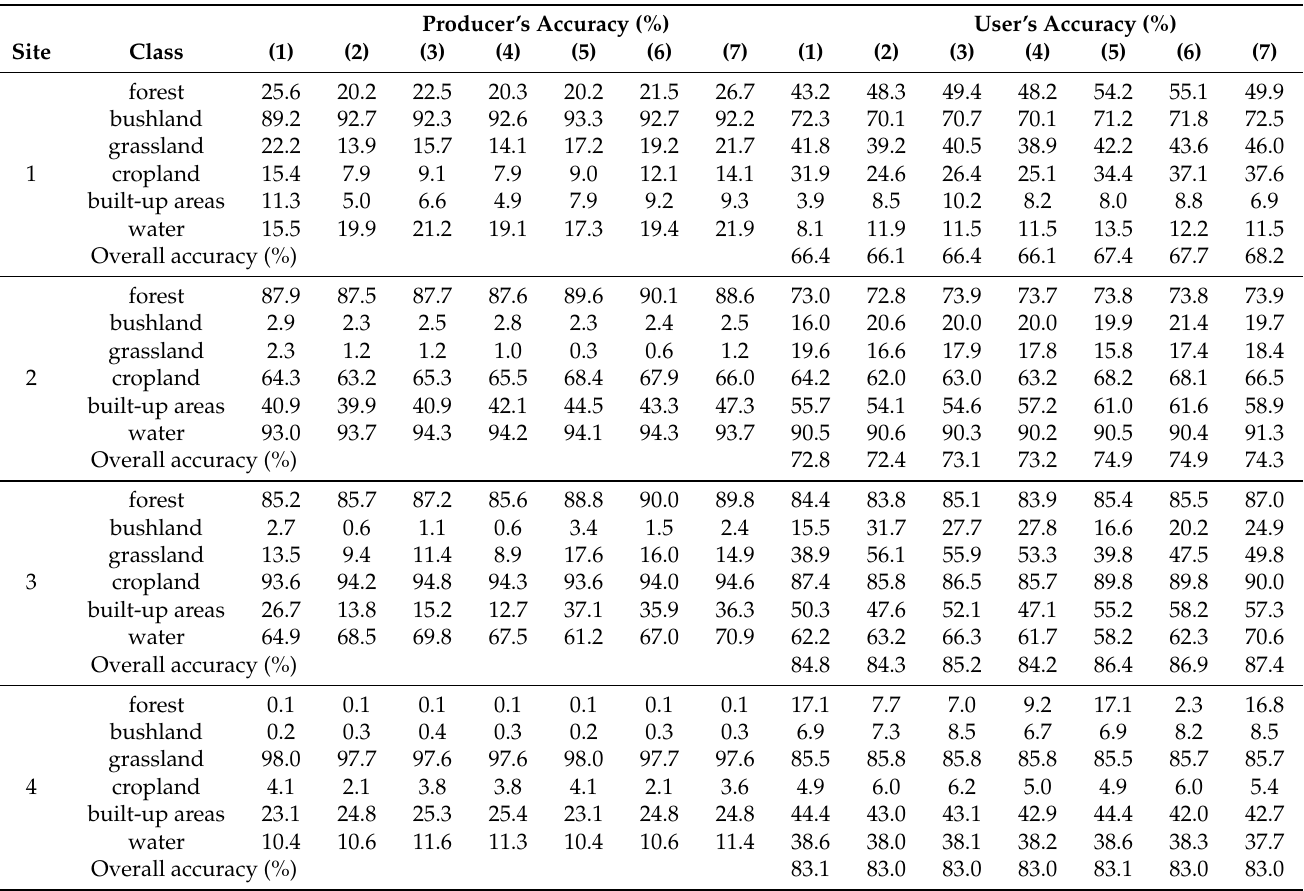
Table 4. Accuracy assessment of land cover classifications based on gap-filled images using (1) SAMSTS, (2) Akima spline, (3) Steffen spline, (4) OTB spline, (5) MOPSTM, and (6) STIMDR gap- filling methods, and (7) original images for Sites